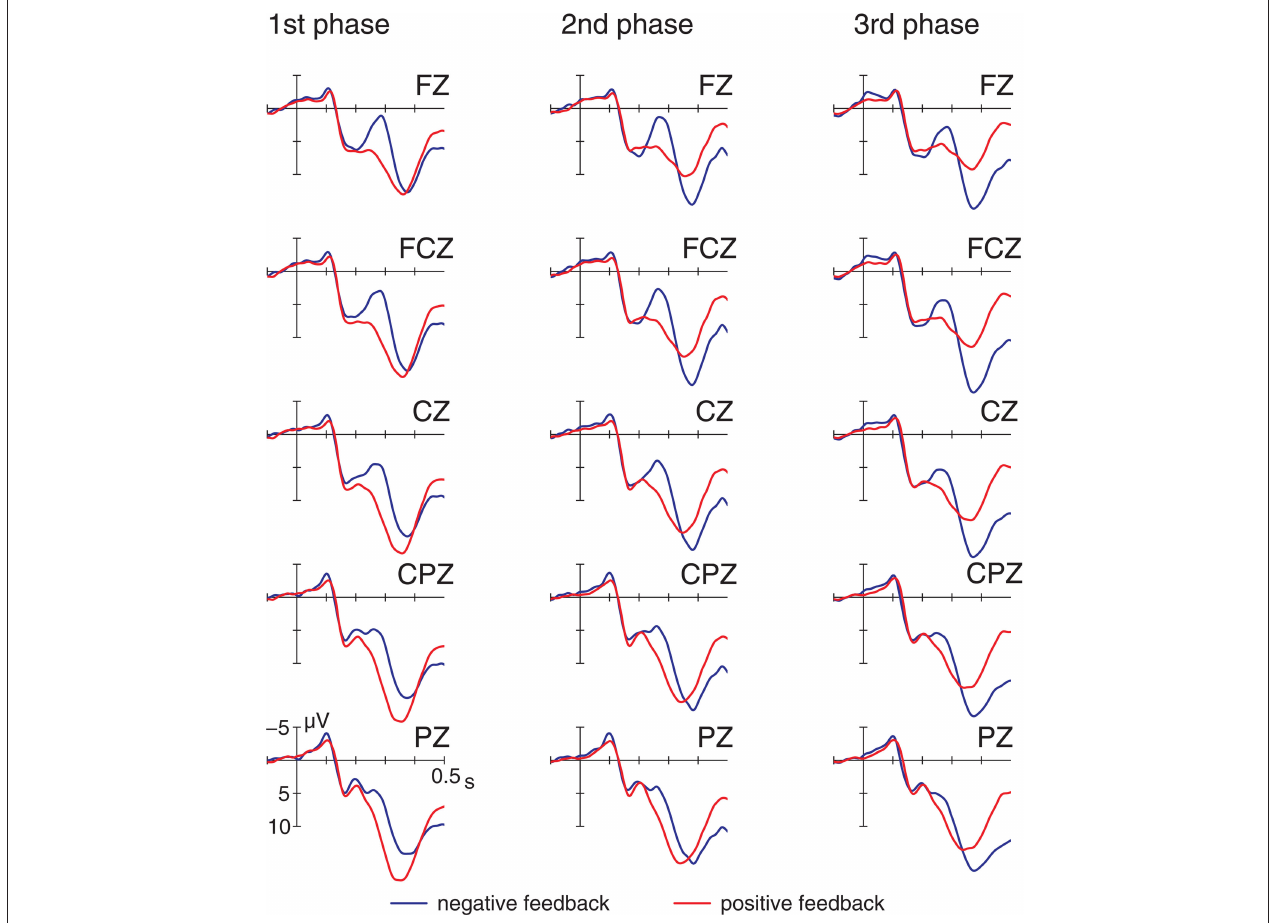
FiguRE 3 | Event-related potentials at midline electrodes elicited by positive and negative feedback for all three learning phases.